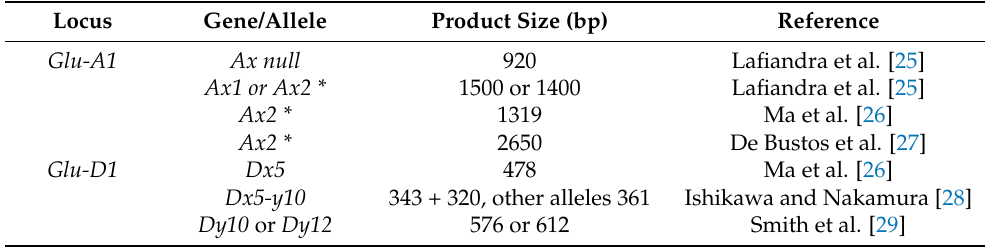
Table 1. PCR primers used for the amplification of specific HMW-Glu genes.